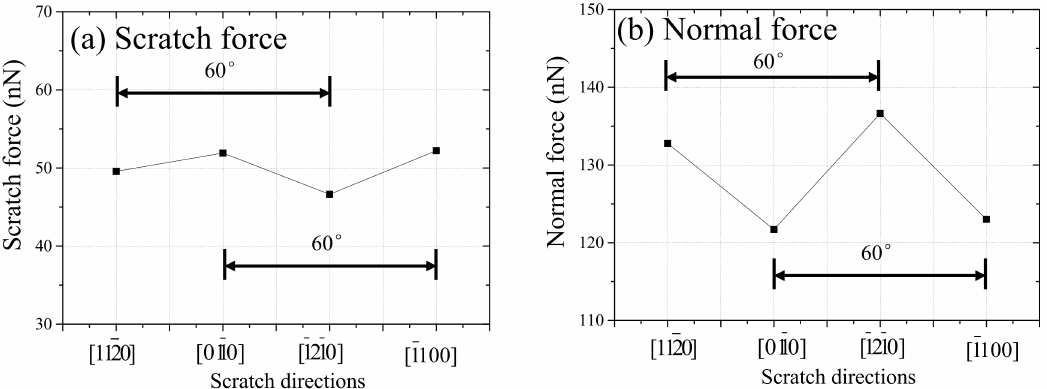
Figure 11. The relationship between scratch direction and ( a ) scratch force and ( b ) normal force, respectively